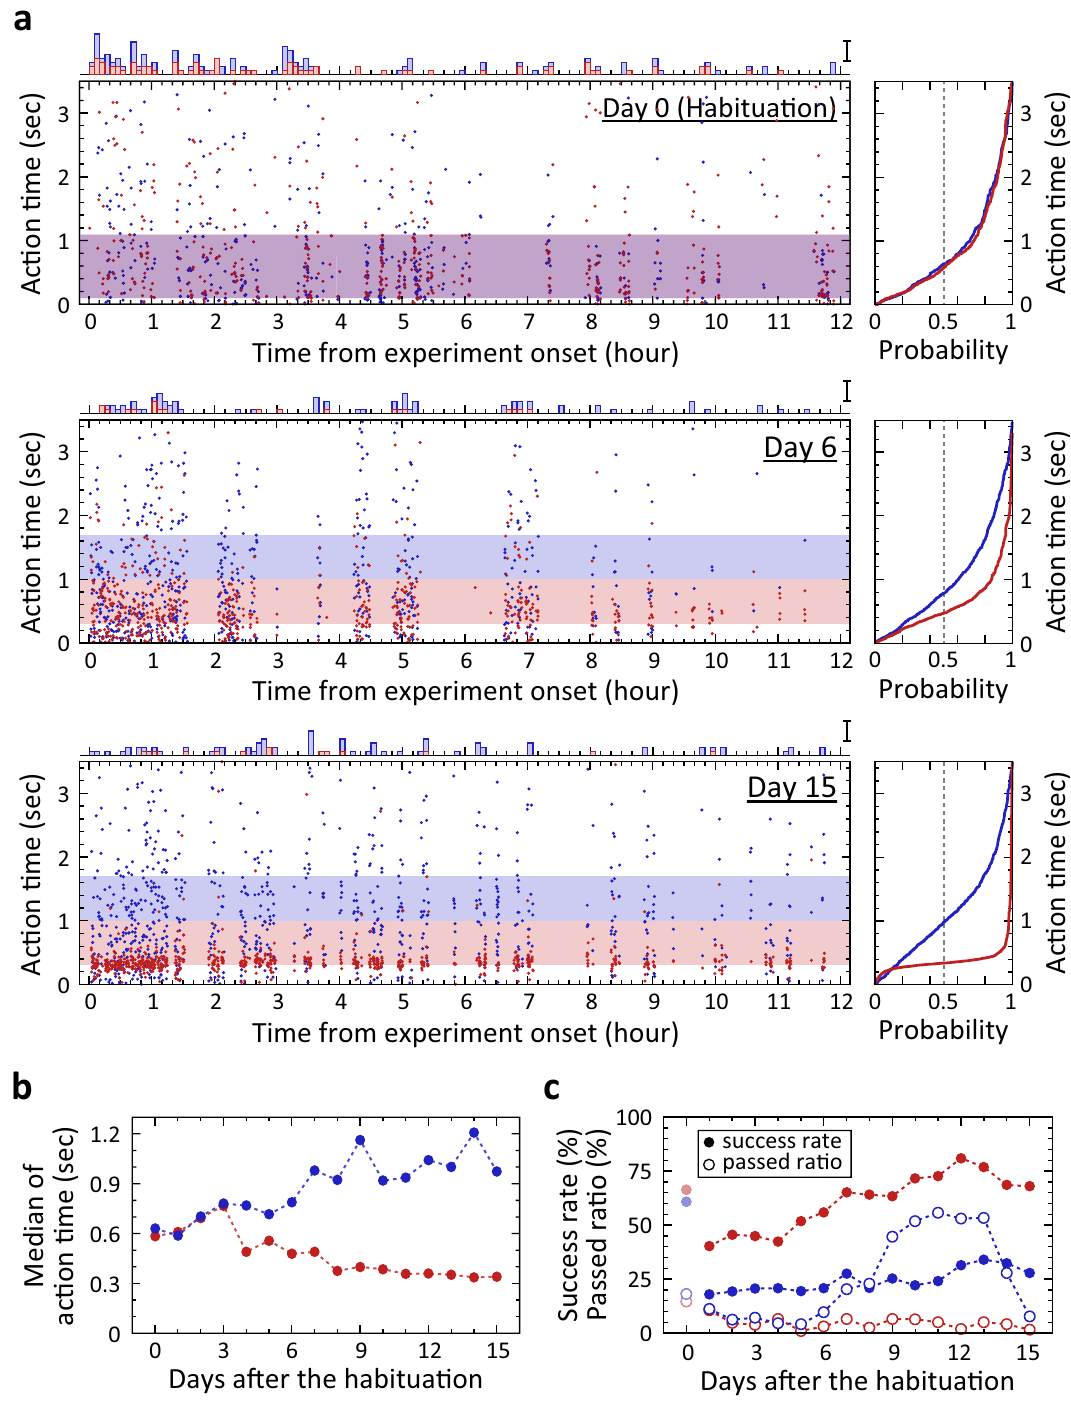
Figure 2. Learning process of the task in a representative guinea pig. ( a ) Action time for each trial of the task and its cumulative distribution. Left panels: Raster plots of action time on Days 0, 6, and 15. Red and blue dots indicate the time in ‘short’ and ‘long’ trials, respectively. This colour assignment for these cues is applied to all panels in this figure. The horizontal purplish band in Day 0 shows the overlapped R(+) time windows for ‘short’ cue and ‘long’ cue, 100–1100 ms. The horizontal reddish and bluish bands in Day 6 and Day 15 show R(+) time windows for ‘short’ cue and ‘long’ cue, respectively. These were 300–1000 ms and 1000–1700 ms, respectively. Histograms on each raster plot show the number of abandoned trials for each cue in the day. Bin width is 5 min. Scale bar is 5 abandoned trials. Right panels: Cumulative distribution of action time for each cue. The intersection of vertical dashed line and the probability curve is the median shown in ( b ). ( b ) Gradual separation of the two medians of action time for these cues in the guinea pig. ( c ) Change of success rate and abandoned ratio over days of experiment in the guinea pig. Filled and open circles indicate the success rate and abandoned ratio, respectively. The rate and ratio in Day 0 (habituation) are shown in faint